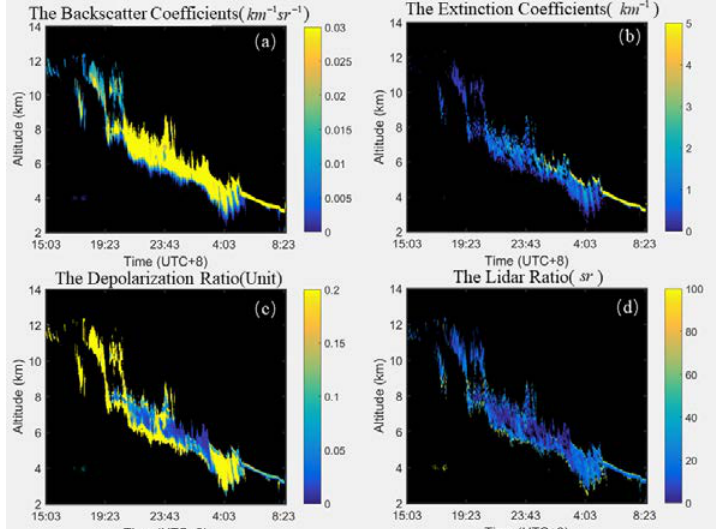
Fig.3. The retrieval results of cloud evolution in Zhoushan from 15:03pm, 15 April 2019 to 8:23am, 16 April 2019. These four pictures are: (a) the backscatter coefficients; (b) the extinction coefficients; (c) the depolarization ratio; (d) the extinction-to- backscatter